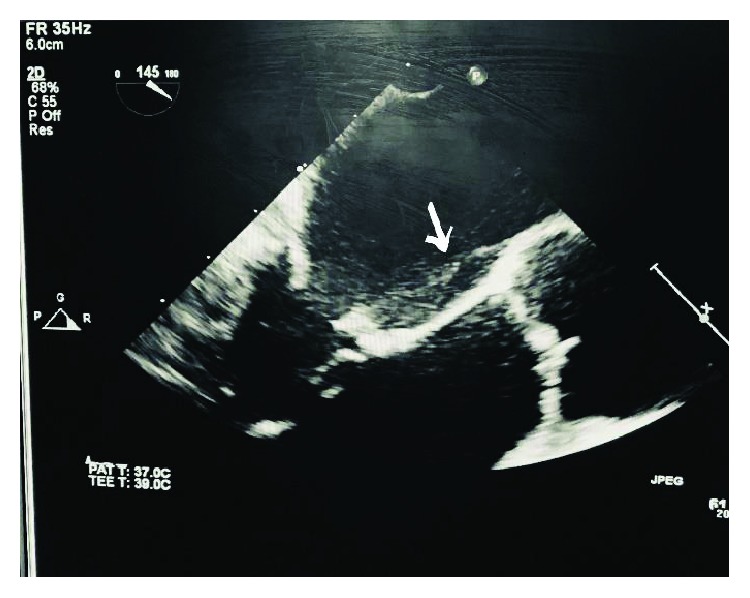
Preop ECHO showing mild focal bileaflet (anterior > posterior) leaflet prolapse with moderate to severe MR. EF was 45%.